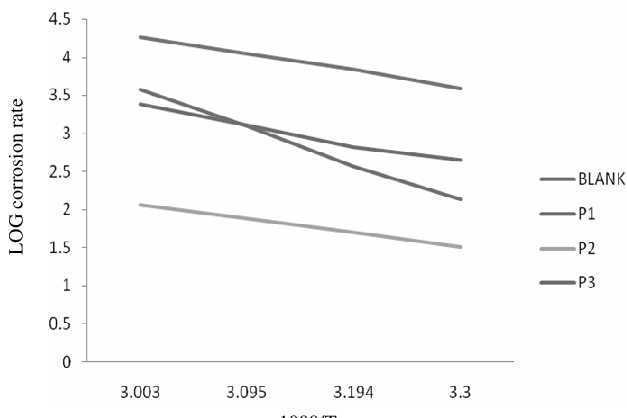
SO solution in the 2 4 SO in the presence 2 4